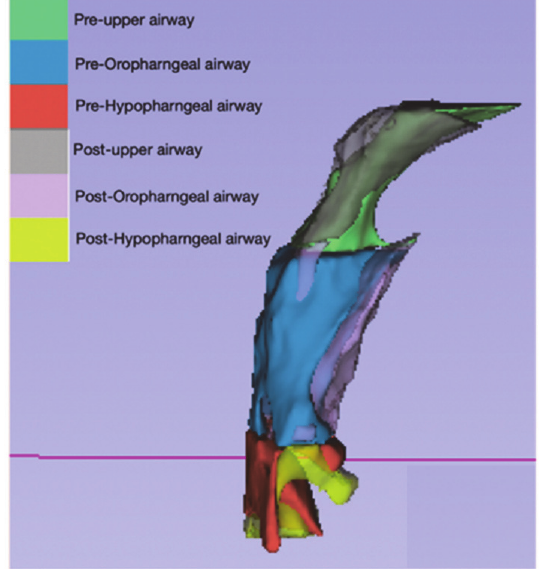
Figure 3. The 3D model images in Figure 2 of Case-3 depict the superimposition of the pharyngeal airway volume. The pharyngeal airway has been divided into three regions namely, the upper airway, the oropharyngeal airway, and the hypopharyngeal airway, each represented by a different color. Our findings indicate that the volume of the pharyngeal airway increased overall after treatment, as seen in the post-treatment images.